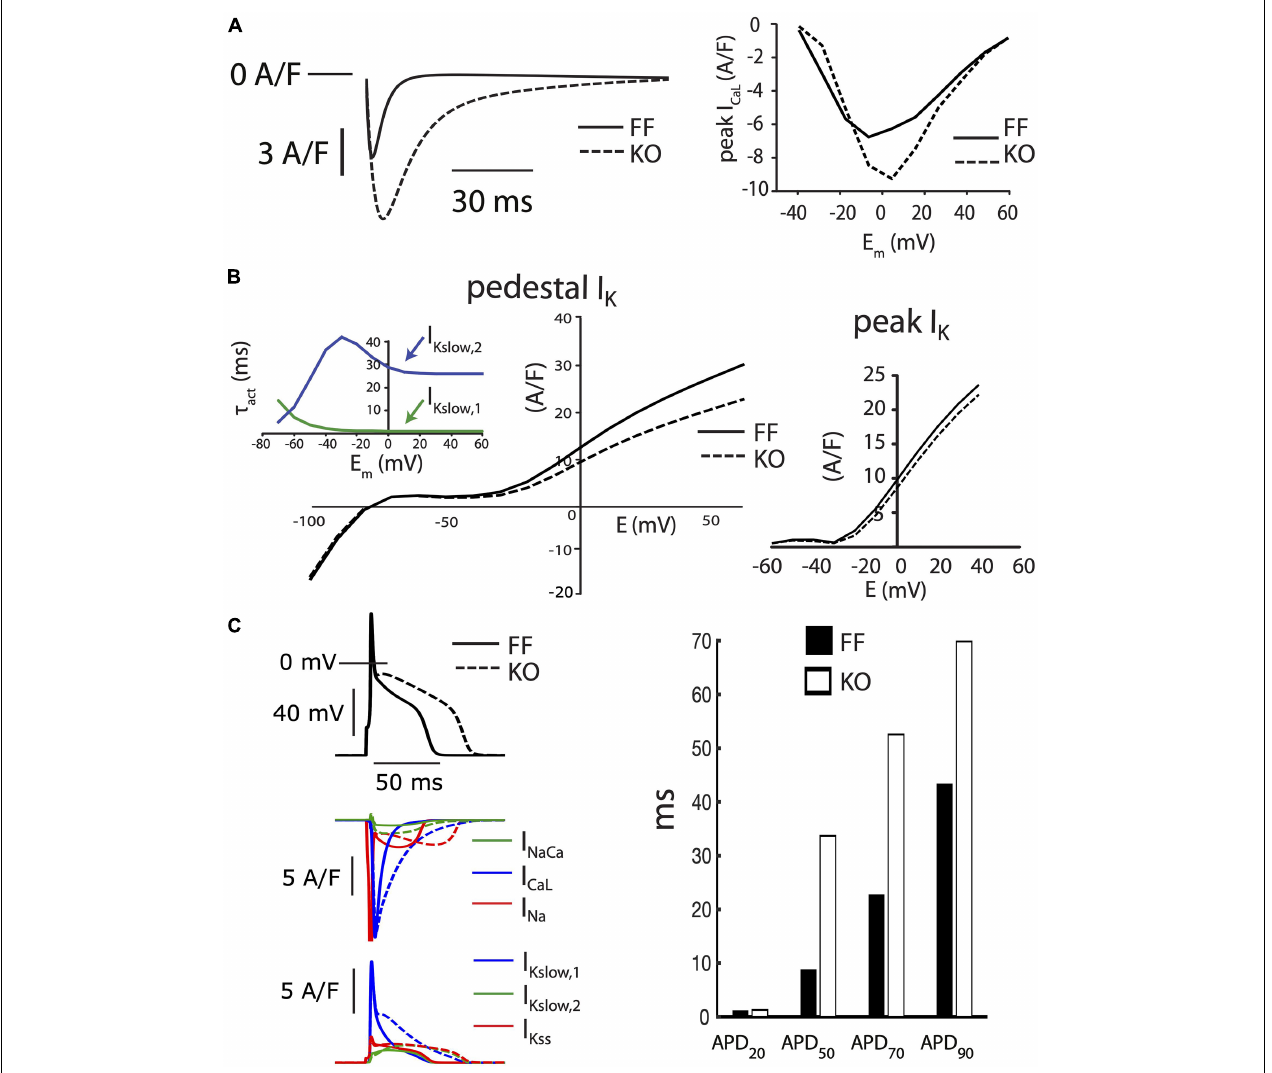
FIGURE 5 | Baseline FF and KO computational models. (A) I CaL in the KO model was parameterized to permit the markedly slowed I CaL inactivation accompanying loss of SR calcium release (left panel) and moderately increased peak current observed in KO myocytes (right panel). (B) Conductances for the slower activating component of I Kslow (Kv2.1, I Kslow , 2 ) and the steady state K + current ( I Kss ) were both reduced by 25% to fit end-pulse “pedestal” total I K (main left panel). Simulated currents were assessed as the sum of all end-pulse K + currents as for the experimental measurements shown in Figure 2 , where this compound current is referred to as I Kp . To simultaneously fit the pedestal and peak components of the compound I K , as well as differences in I CaL and steady state APD, it was necessary to implement the slower activation kinetics of Kv2.1/ I Kslow , 2 (inset left). Peak I K was straightforwardly fit through scaling the conductance of I to , f in both the FF and KO models (right panel). (C) Together, these alterations resulted in slowed intermediate repolarization (APD 50 and APD 70 ) similar to that observed for KO myocytes. However, the slower early repolarization and rapid late repolarization in KO cells were much more difficult to capture with models that remained faithful to the voltage-clamp measurements. See Supplementary Table 1 for complete details of differences between these two baseline